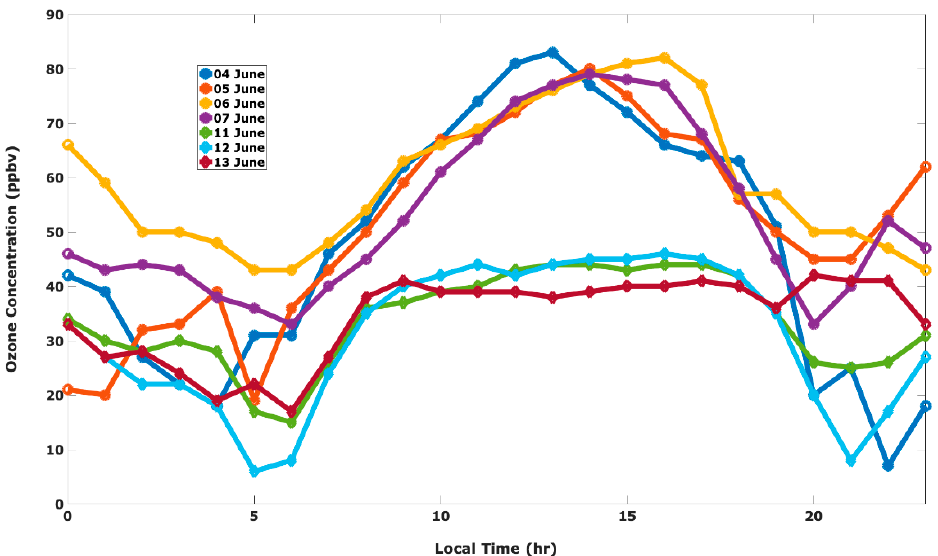
Figure 3. Ozone concentrations (ppbv) for both the high and low ozone episodes for the city of El Paso (ELP). Source: TCEQ CAMS 12. Note: 4–7 June 2017 are high ozone days and 11–13 June 2017 are low ozone